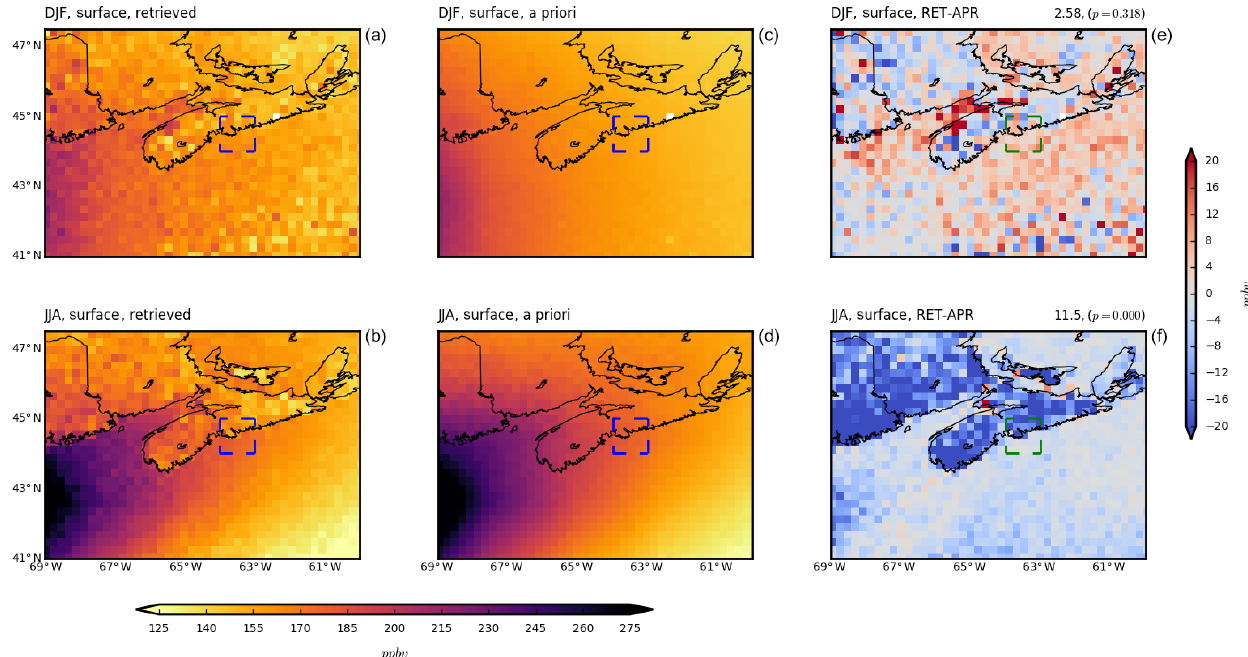
Figure 6. Seasonal median L2 (these maps were created from L2 data that were interpolated to a regular 0 . 25 ◦ × 0 . 25 ◦ grid for ease of plotting.) retrieved VMR (a, b) , a priori VMR (c, d) , and RET–APR (e, f) at the surface profile level in DJF (a, c, e) and JJA (b, d, f) . Values to the right above RET–APR plots equal ( L2 retrievals over water ) − ( L2 retrievals over land ) for plotted area (data were first binned according to L2 surface index); numbers in brackets correspond to significance of mean difference using a two-tailed Student t test. Blue or green dashed squares represent the outline of the L3 grid box that contains